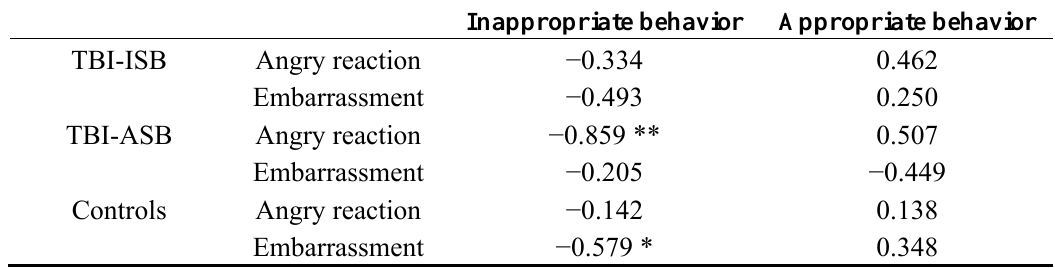
Table 5. Spearman’s rank order correlations by group between inappropriate and appropriate behaviors, expectations of angry reactions from others and of feelings of